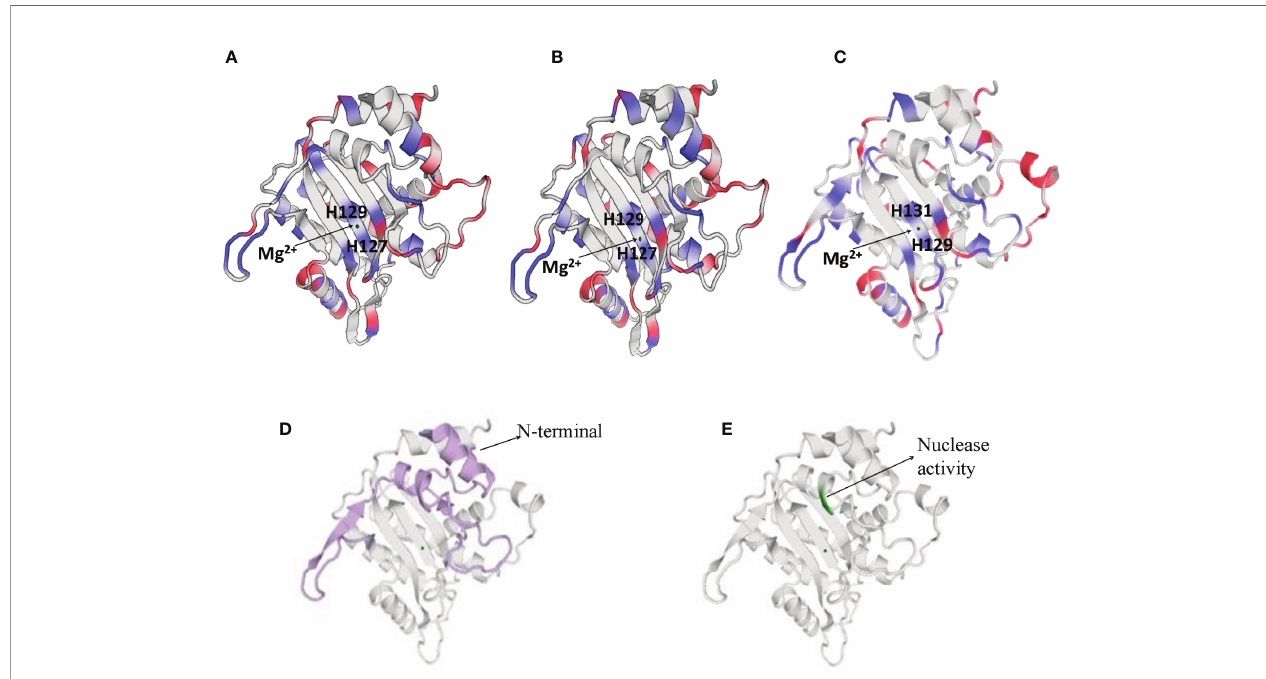
FIGURE 2 | Cartoon presentation of N-terminal domain of NS1 protein of (A) H-1 PV (https://swissmodel.expasy.org/interactive/Yag5kS/models/), (B) MVM (https:// swissmodel.expasy.org/templates/4r94.1) and (C) CPV (https://swissmodel.expasy.org/repository/uniprot/P12929). The catalytic DNA-nicking activity of viral replication proteins (nickase domain) is linked with the divalent metal ion coordination site, which comprises the conserved HUH motif (two histidines fl anking a hydrophobic amino acid). (D) Colored portions depict N-terminal of CPV2.NS1 protein. (E) Green color represents the region with nuclease activity in CPV2.NS1